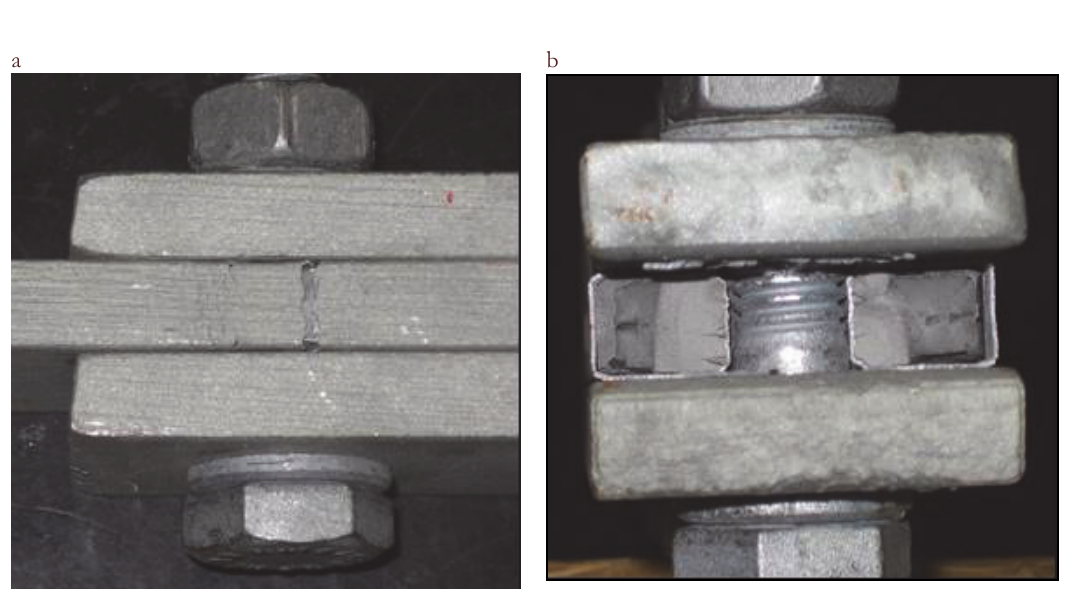
Figure 4: Typical failure from the hole corresponding to the first bolt of the connection. (a) lateral view and (b) upper view.